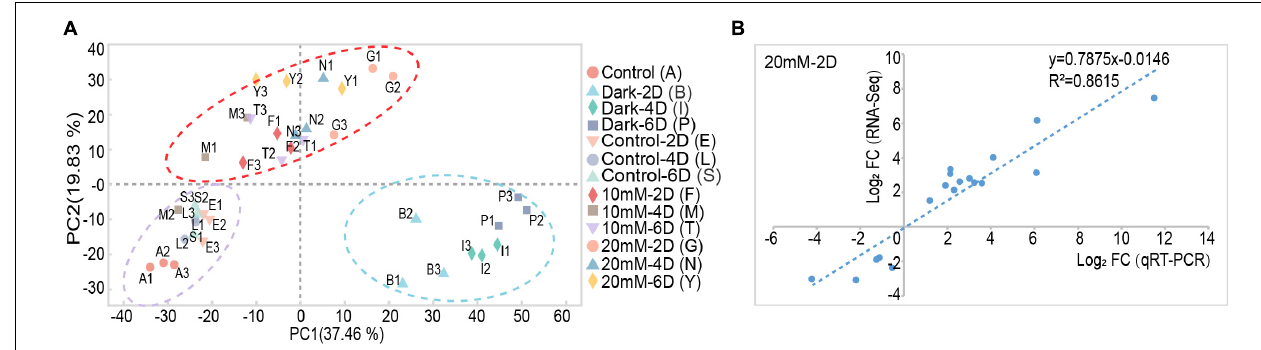
FIGURE 2 | The PCA analysis and qRT-PCR validation of transcriptome data derived from alkali stress-induced detached leaf senescence in M. truncatula . (A) Principal component analysis (PCA) plot of transcriptome profiles from different conditions. (B) Validation of RNA-seq data by qRT-PCR analysis. Correlation of expression changes observed by RNA-seq ( Y -axis) and qRT-PCR ( X -axis) relative expression levels from log 2 fold change of 25 genes in 20 mM NaHCO 3 -light-2 day; data for other groups are shown in Supplementary Figure 2